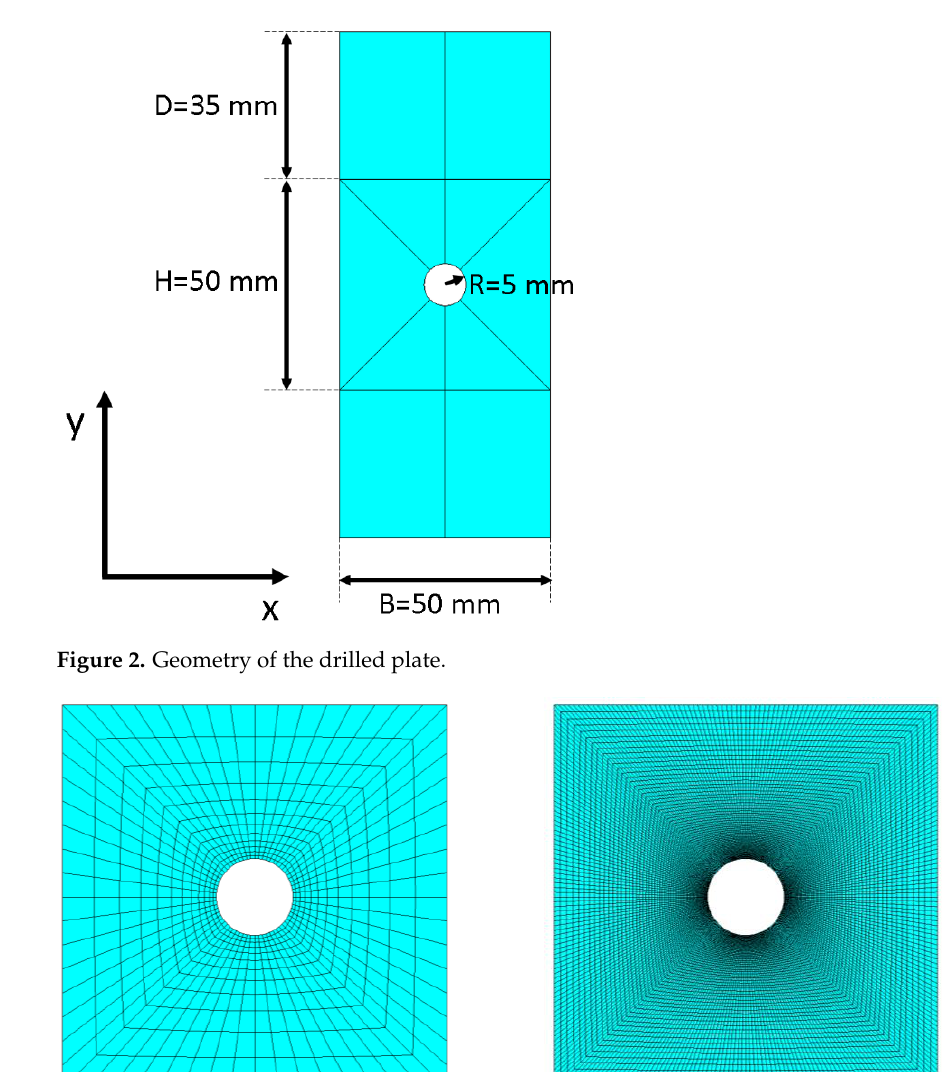
Figure 3. The central square of the plate featuring the coarsest ( left ) and finest ( right ) levels of discretization on the biased mesh.